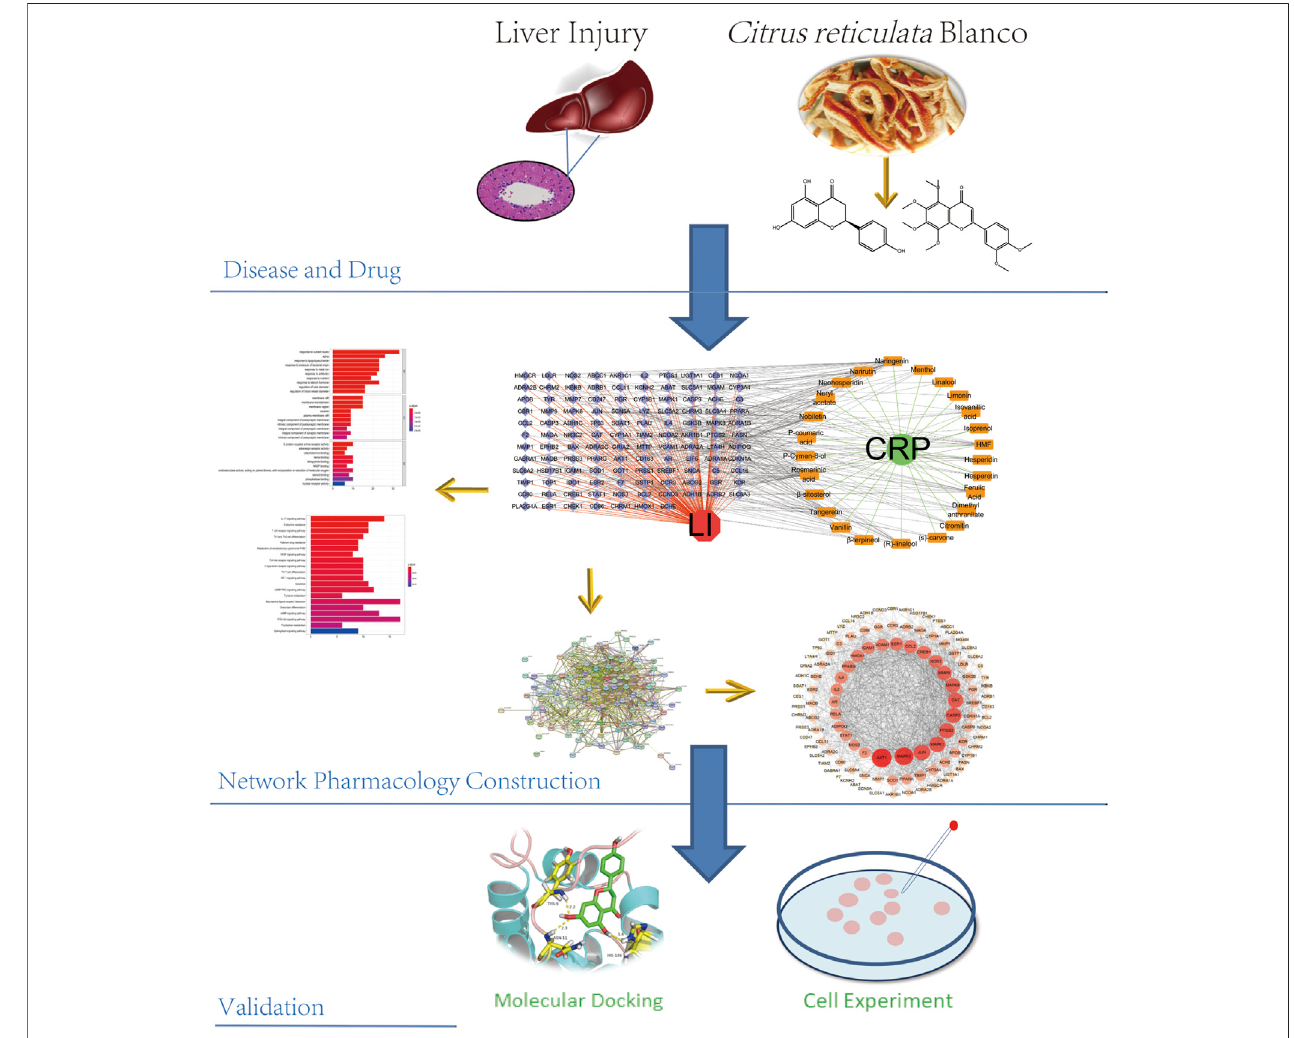
FIGURE 1 | A comprehensive strategy diagram for the study of the mechanism of CRP action on LI.